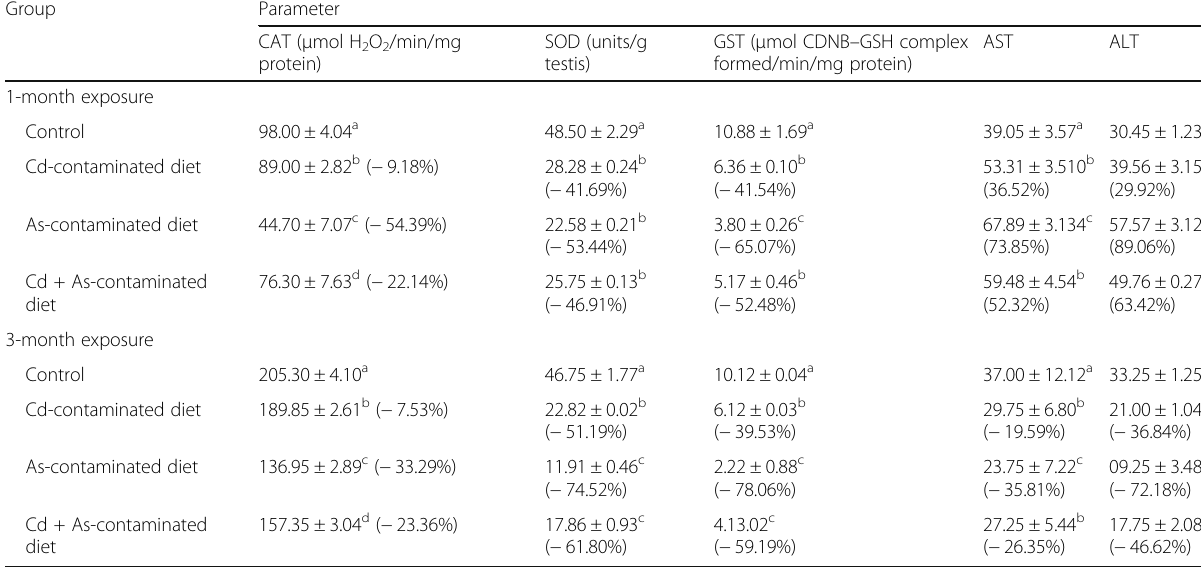
Table 4 Effect of treatment on enzymatic activities in the liver of experimental rats Group